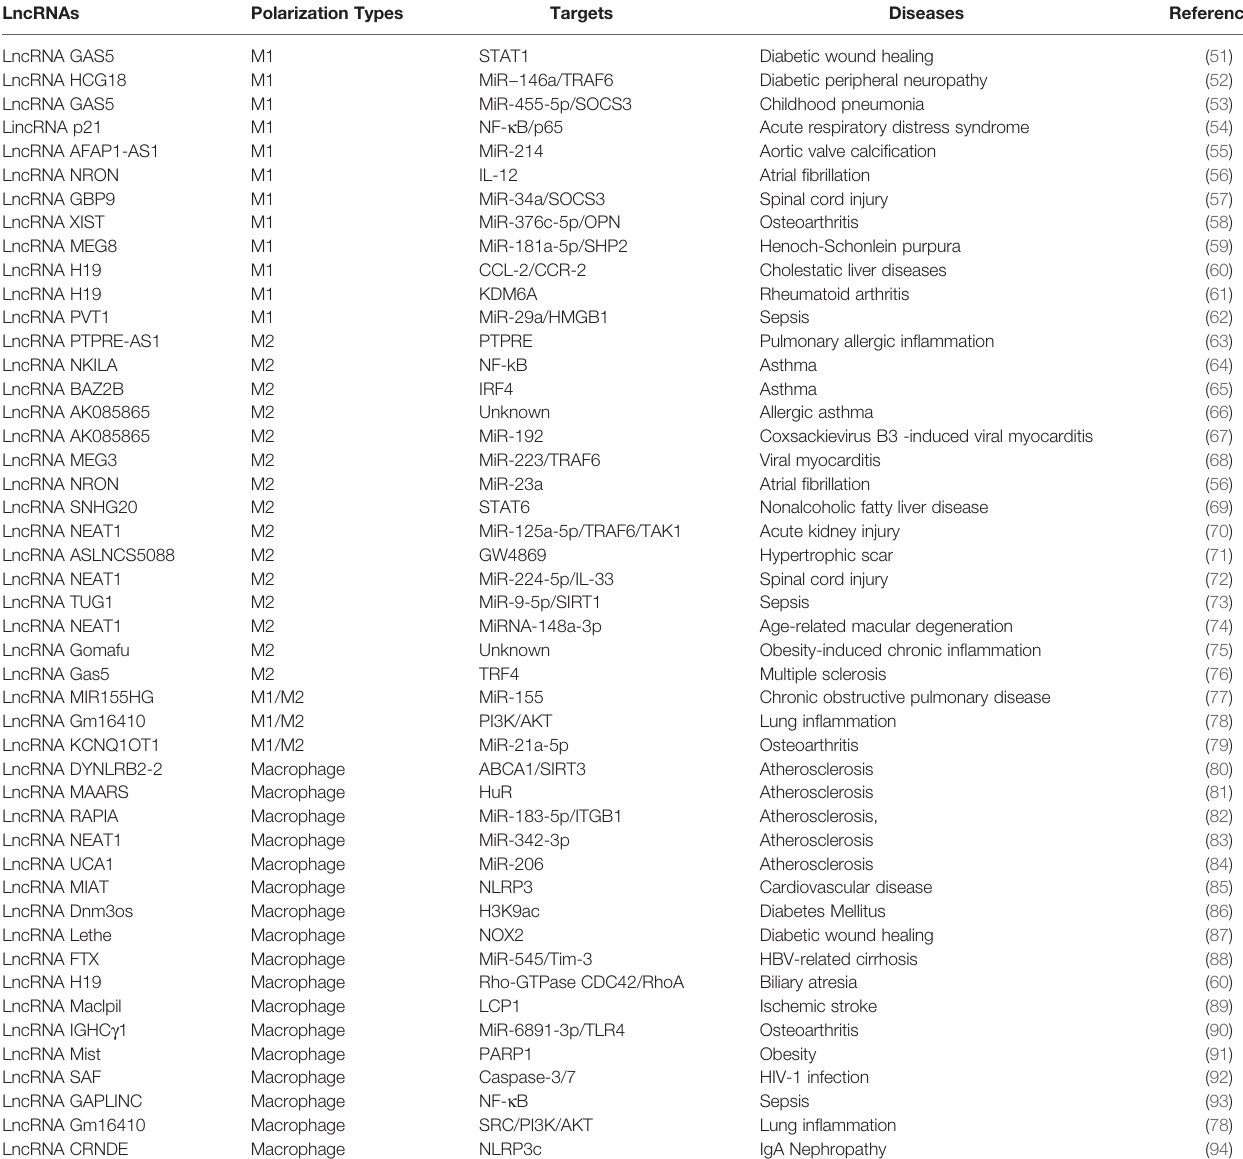
TABLE 2 | LncRNAs regulate polarization types of M j s and targets in other diseases.